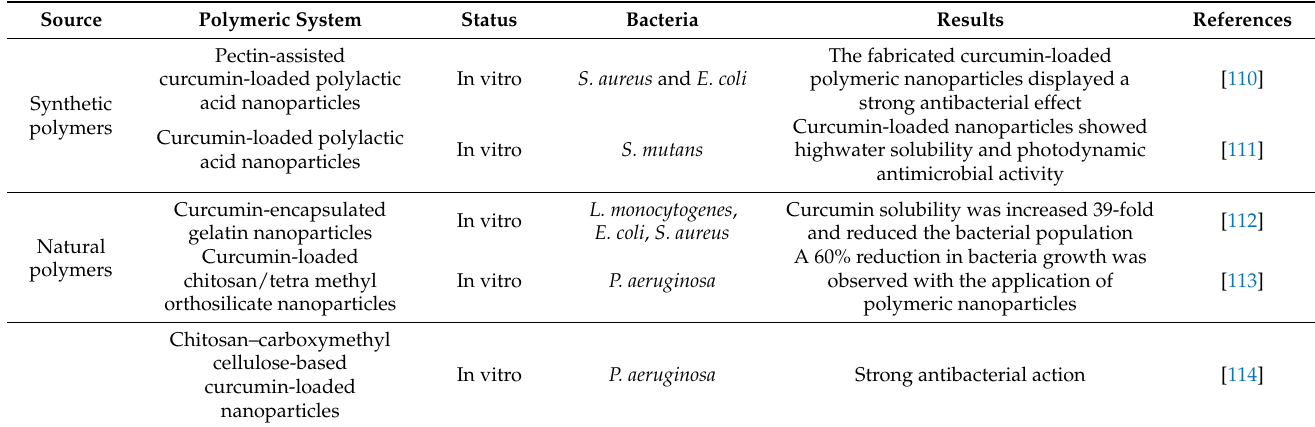
Table 2. Curcumin-loaded polymeric nanoparticles and their antibacterial